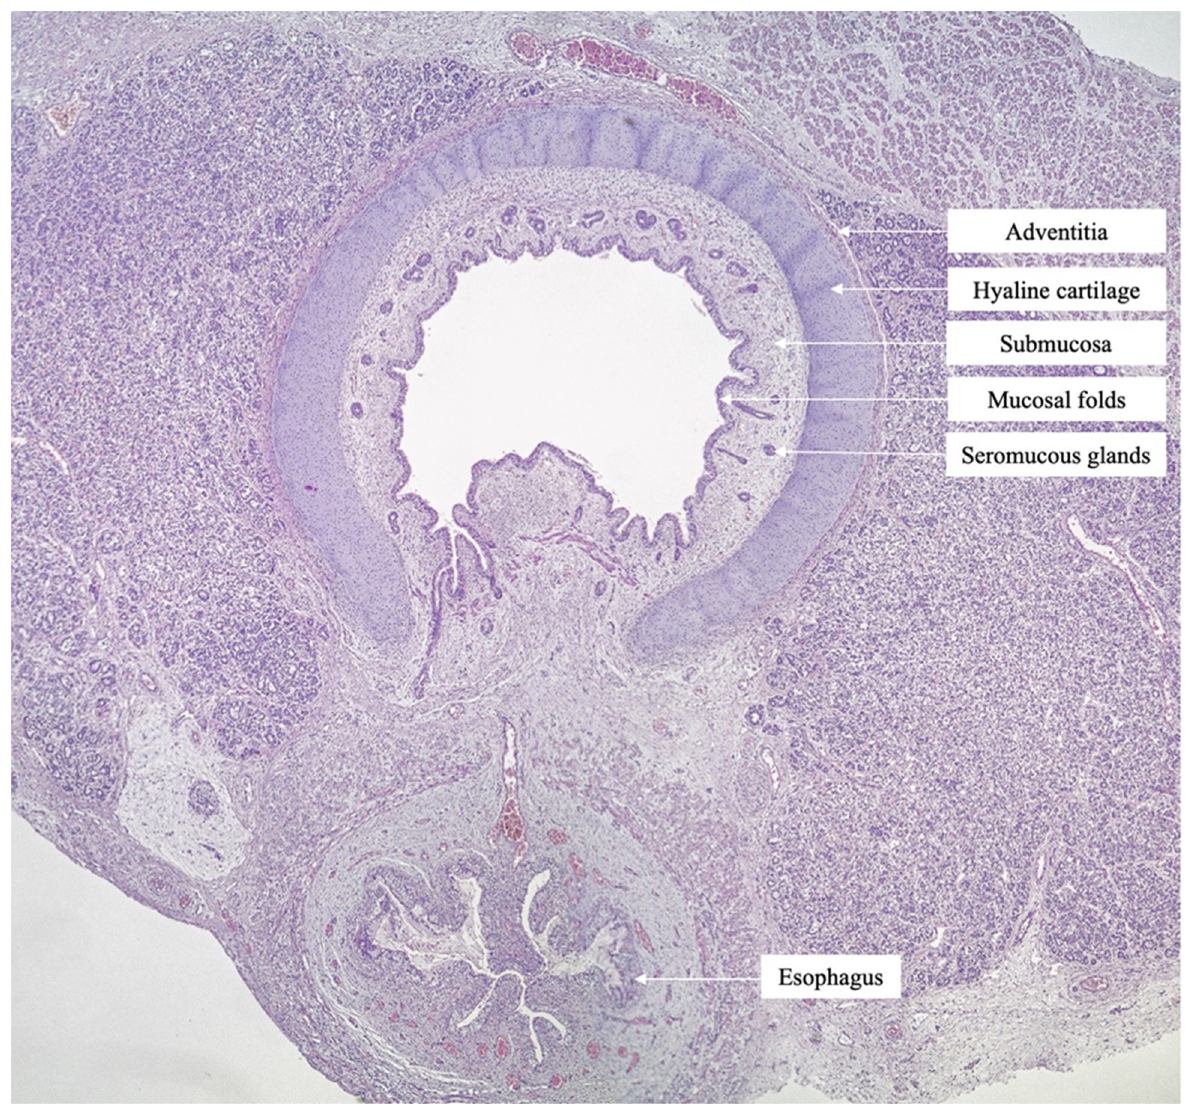
Figure 6. Histopathological aspect of the trachea with open lumen, above the obstructive level, composed of hyaline cartilage, tracheal mucosa, trachealis muscle and longitudinal muscle—behind the trachealis (H.E., 10×).